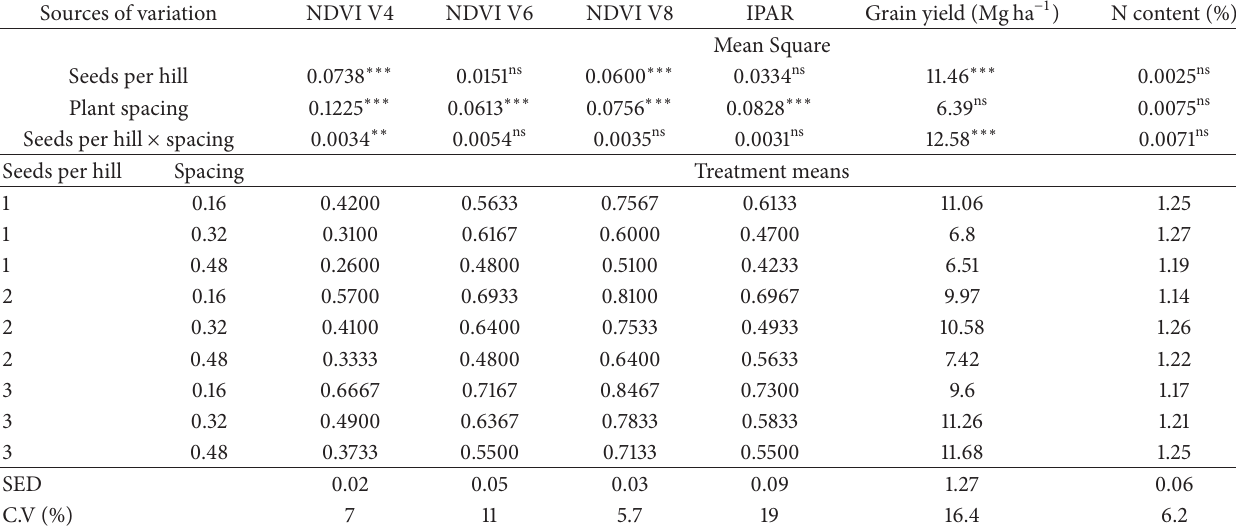
Table 3: Analysis of variance for normalized difference vegetation index (NDVI) values, intercepted photosynthetically active radiation (IPAR), grain yield (Mgha − 1 ), and N content (%) at Efaw, 2012. Sources of